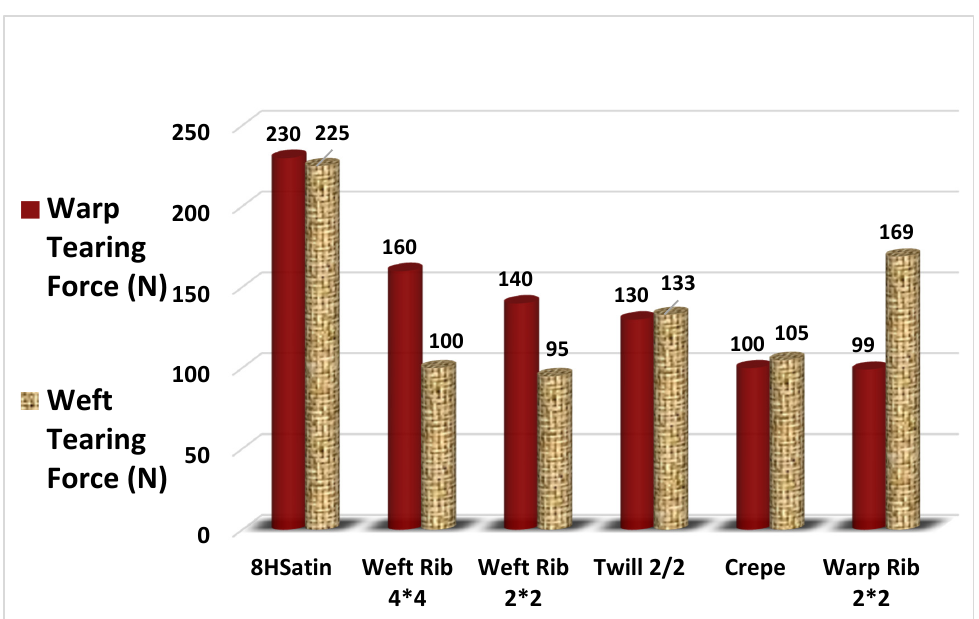
Figure 1. Effect of fabric structure on the tearing force in the warp and weft directions. Reproduced with permission from [48]. Copyright 2018 Elsevier.